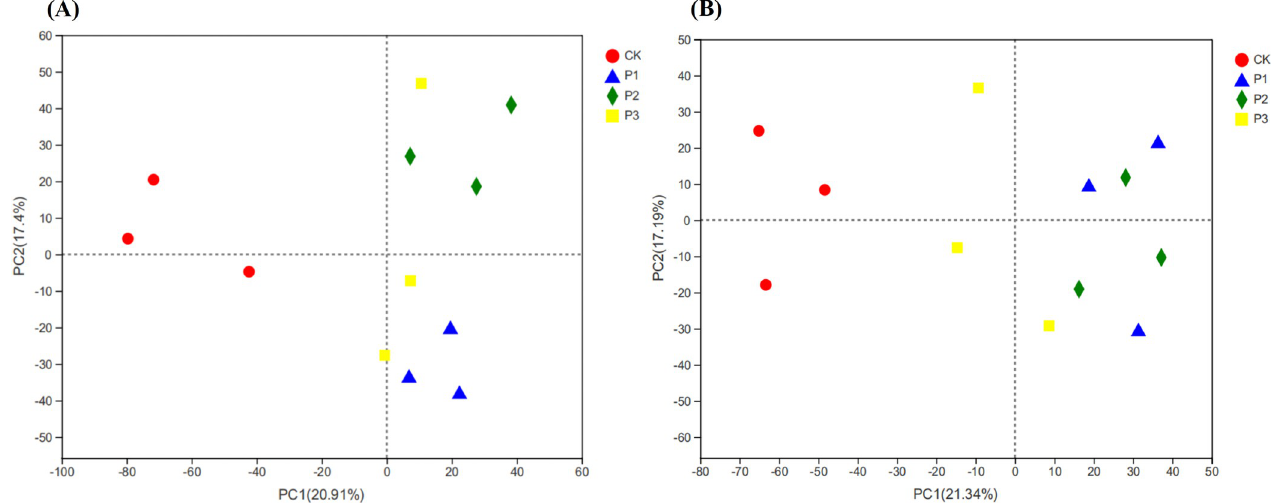
Fig 4. The PCA analysis of bacterial community based on OTU level. A is 0–30 soil layer, B is 30–60 cm soil layer.